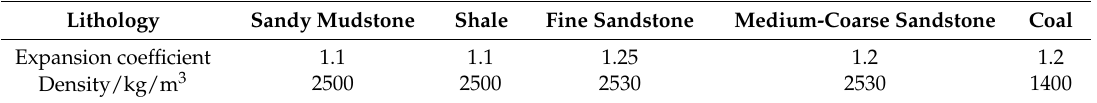
Table 1. Expansion coefficients of the overlying